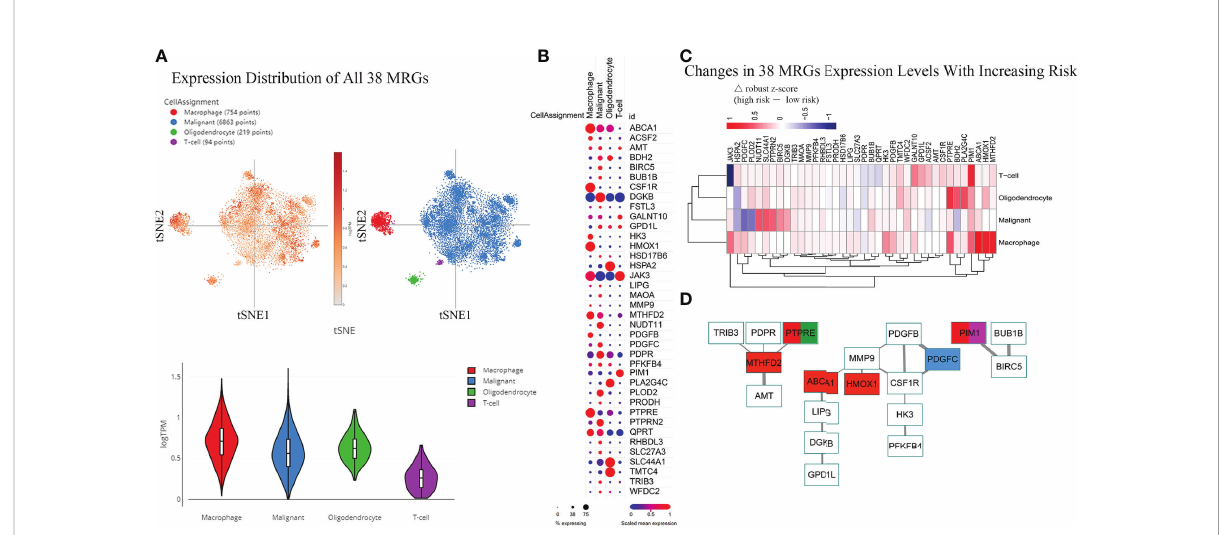
FIGURE 5 Differences in the Expression Distribution of 38 MRGs Between Risk Groups in the Single-cell RNA-seq IDH WT GBM Dataset. The risk level of each sample in the single-cell RNA-seq IDH WT GBM dataset (n = 28) was de fi ned based on the relative expression distribution of the 38 MRGs (Figure S8). The data indicated that four main cell types are present in GBM tissue: macrophages, malignancies, oligodendrocytes, and T cells. (A) Overall expression distribution of signature genes (all 38 MRGs) in four main cell types. (B) Expression distribution of 38 MRGs in four main cell types. (C) Expression alterations of 38 MRGs in four main cell types with increased metabolic risk. (D) Protein – protein interaction network of the 38 MRGs. The thickness of the line indicates the level of the combined score (0.4~1.0). Red indicates MRGs that are differentially expressed in macrophages between different risk groups (| △ robust z score| > 0.5, (C) . Blue indicates the MRG in malignant cells. Green indicates the MRG in oligodendrocytes. Purple indicates the MRG in T